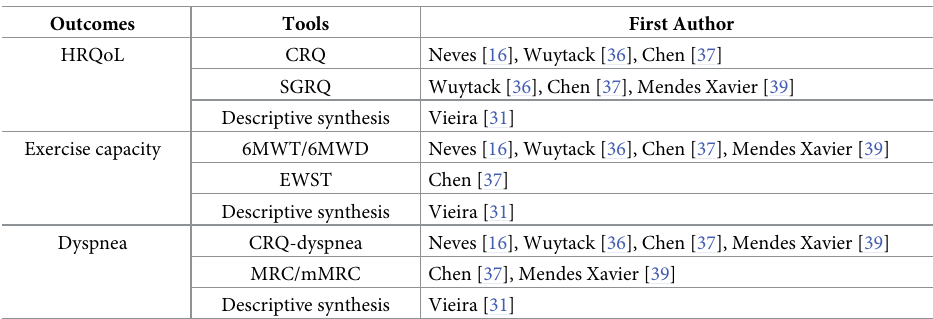
Table 4. HPR versus